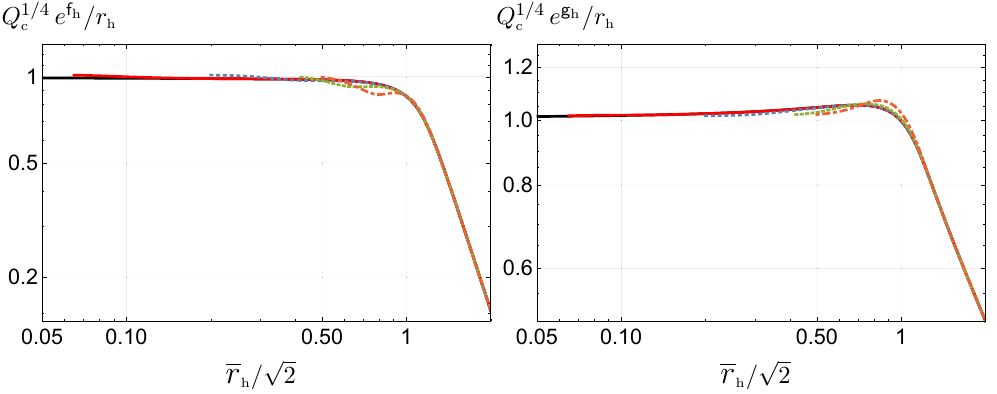
(see legend in figure q